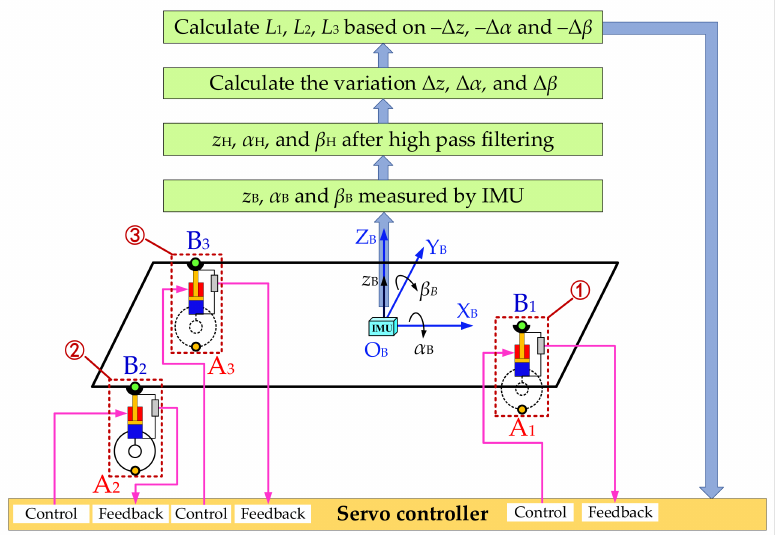
Figure 5. Schematic diagram of the principle of the control